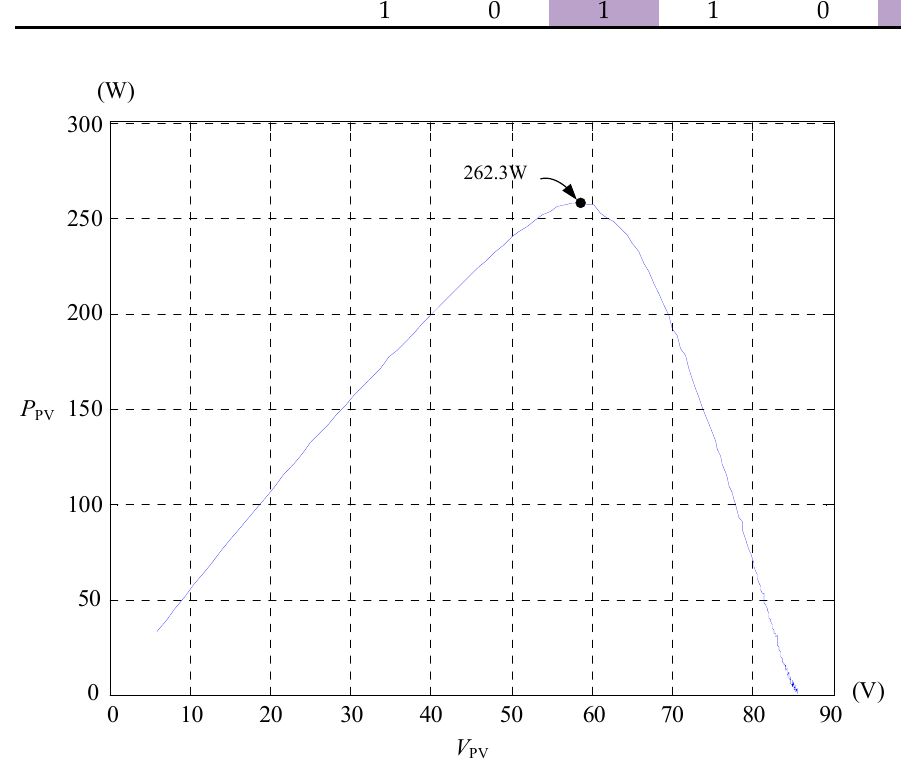
Figure 5. A single experimental P–V characteristic curve for all optimized configurations in Case 1.